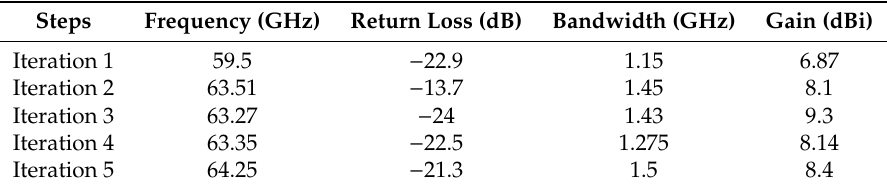
Table 1. Simulation results of each patch iteration.